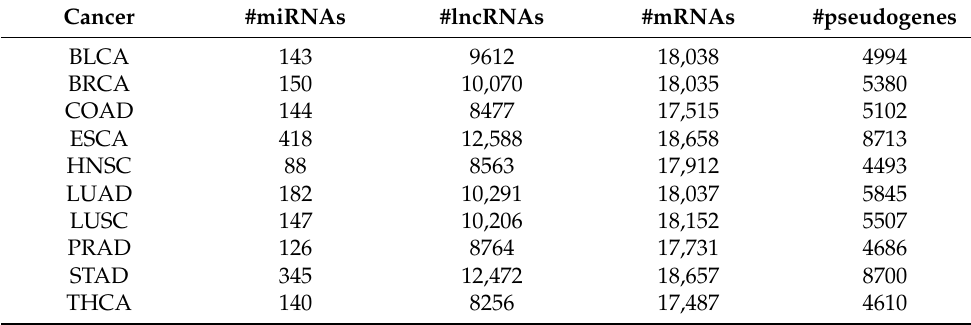
Table 2. The number of miRNAs, lncRNAs, mRNAs, and pseudogenes in ten types of cancer.